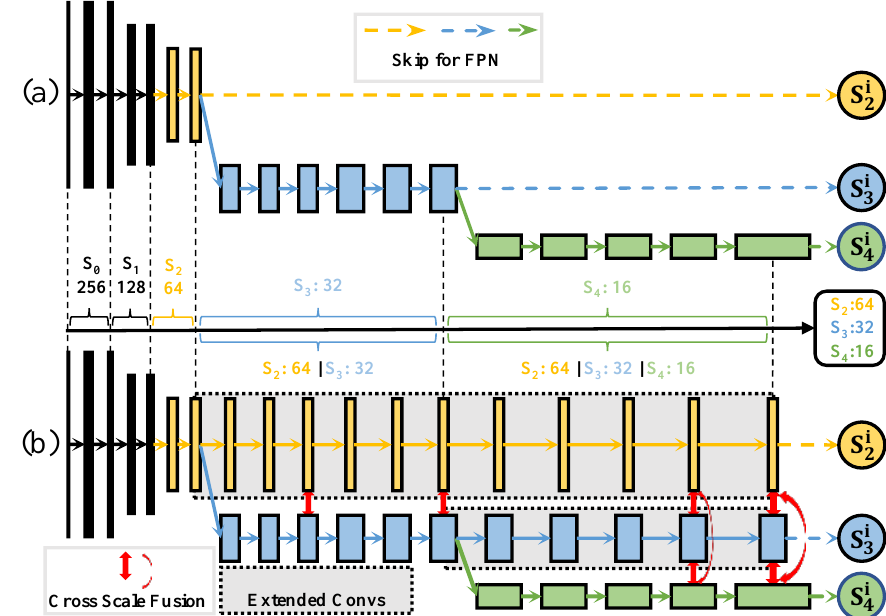
Figure 3. EffNet vs. MEMe-based EEffNet. ( a ) The EffNet. ( b ) The mutually enhanced EEffNet. Compared with ( a ), ( b ) has a more powerful multi-scale representation by using our Extended Convs (gray box), and a more flexible information flow by using our Cross-scale fusion (red arrow). As a MEMe-base backbone, our EEffNet shows how to use MEMe to mutually enhance a